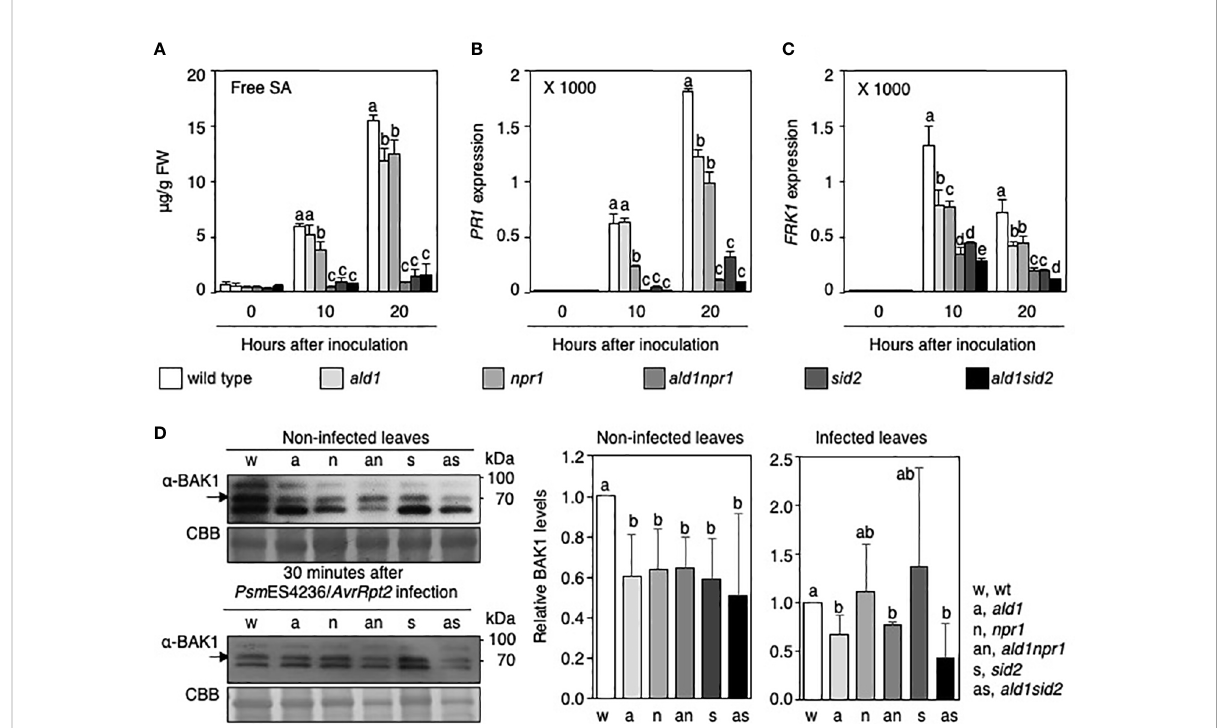
FIGURE 4 ALD1, NPR1, and SID2 are necessary to fully express RPS2-mediated immunity against an avirulent Pseudomonas infection. (A) Free SA levels in the leaves of WT, ald1 , npr1 , ald1npr1 , sid2 , and ald1sid2 plants during avirulent Psm ES4326/ AvrRpt2 infection. Data show averages with standard deviations from fi ve biological replications (n = 5). (B) Deregulation of PR1 transcription in ald1npr1 and ald1sid2 mutants after infection. PR1 expression levels relative to an ACTIN2 gene in non-inoculated leaves of WT plant was set to 1. The columns and bars show the average with standard deviation obtained from three biological replications (number of technical replicates = 3). (C) Relative level of FRK1 mRNA in leaves of Arabidopsis plants infected with Psm ES4326/ AvrRpt2 . We normalized expression levels and presented the results mentioned above (B) . (D) Level of BAK1 in leaves of WT and mutants in the absence or presence of avirulent pathogen infection. Upper, BAK1 protein levels in leaves of non- infected Arabidopsis plants; lower, BAK1 levels after Psm ES4326/ AvrRpt2 infection. Bands not indicated are non-speci fi c. Graphs on the right side of D show the normalized BAK1 levels in Arabidopsis at the indicated time points (average ± standard deviation, n = 3, or 4). Different letters indicate statistically signi fi cant differences ( p < 0.05 [ D ], p < 0.01 [ A-C ], one-way